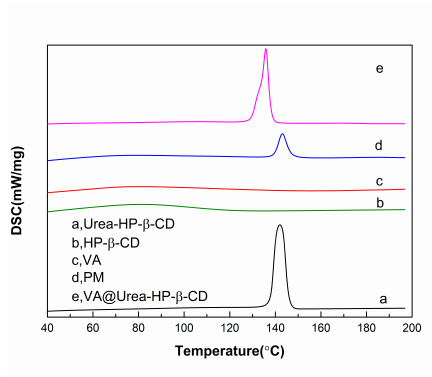
Fig. 2. The XRD graph of (a) HP- β -CD (b) 3:1 Urea-HP- β -CD (c) VA (d) PM (e) VA@ Urea- HP- β